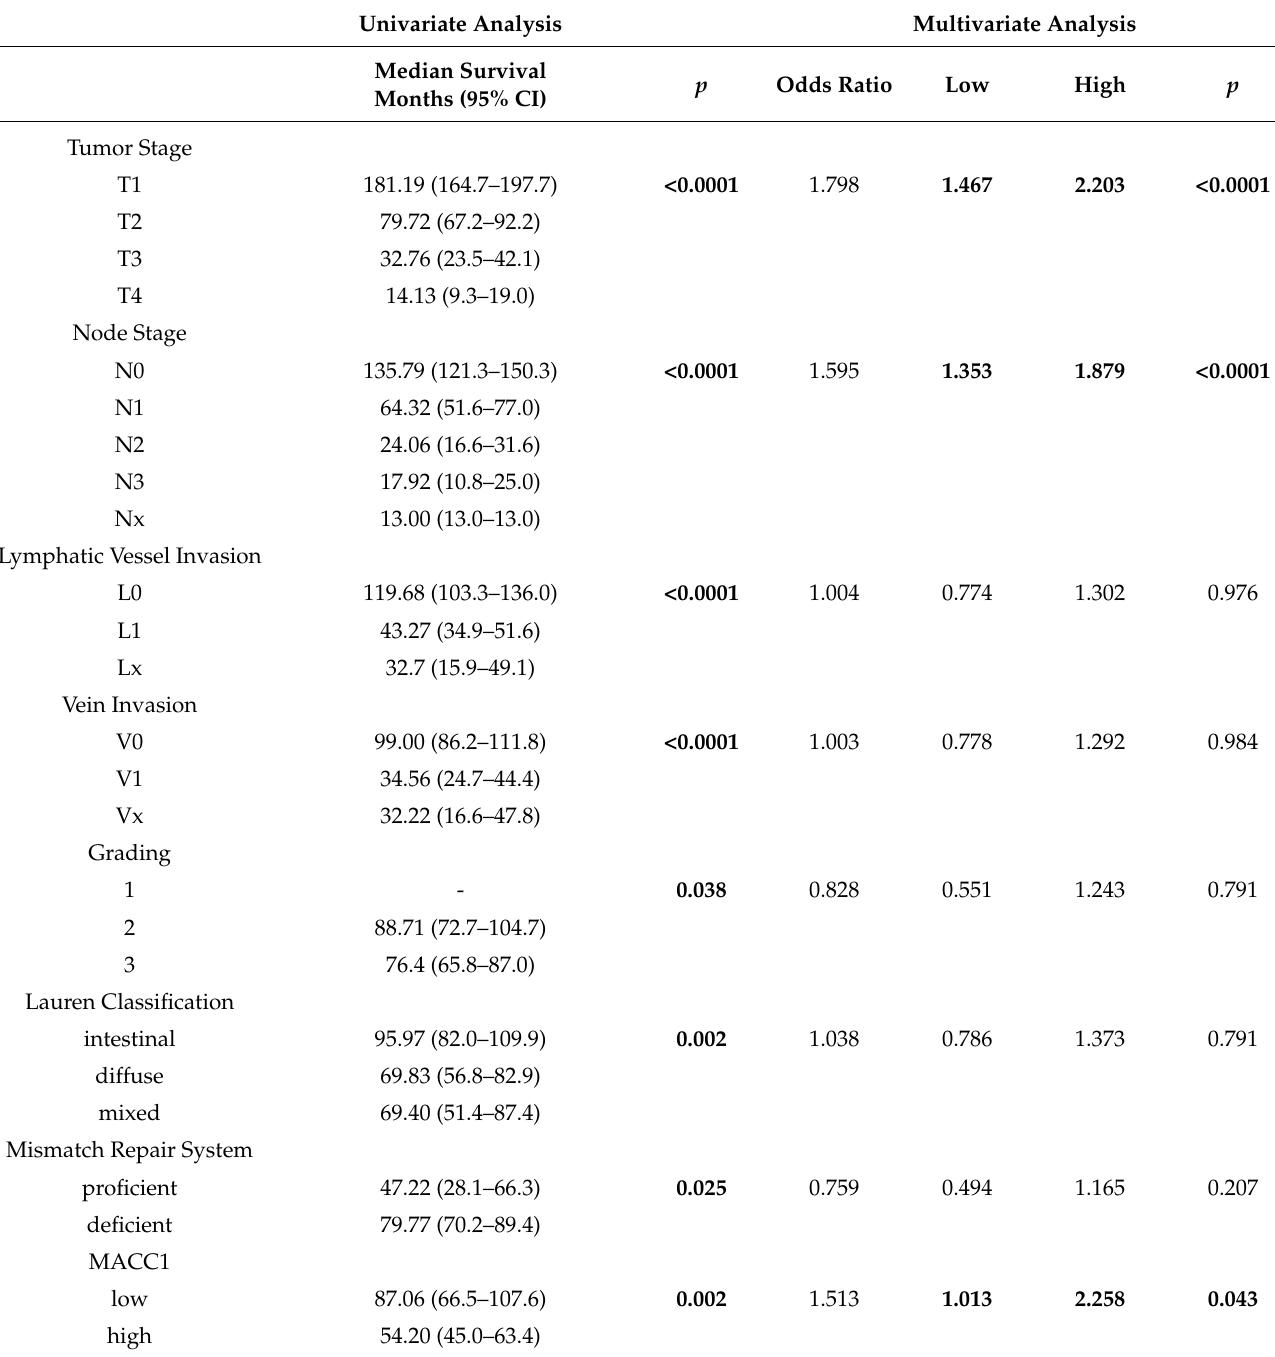
Table 2. Univariate and multivariate analysis of patient survival dependent on pathomorphological criteria. Univariate analysis performed by log-rank and multivariate analysis by Cox’s regression. Univariate Analysis Multivariate